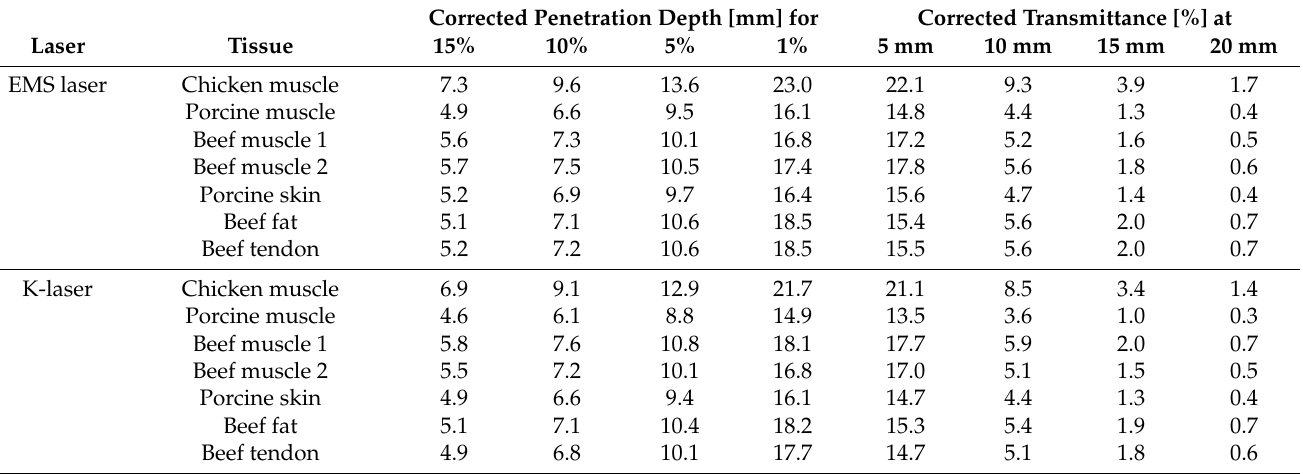
Table 2. Corrected penetration depths in millimeters for given thresholds, and corrected transmittance in percent at given tissue thicknesses. Corrected Penetration Depth [mm] for Corrected Transmittance [%]